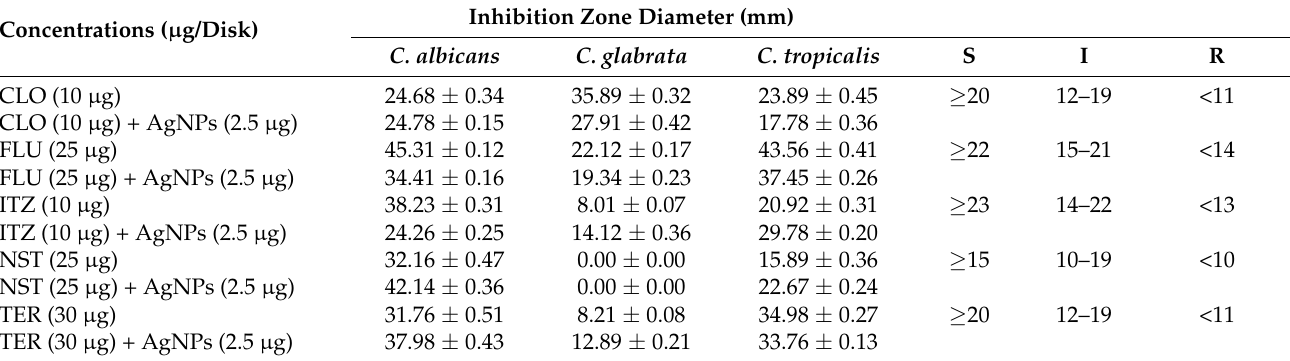
Table 3. Antimicrobial activity of biogenic silver nanoparticles in combination with common antifun- gal agents.